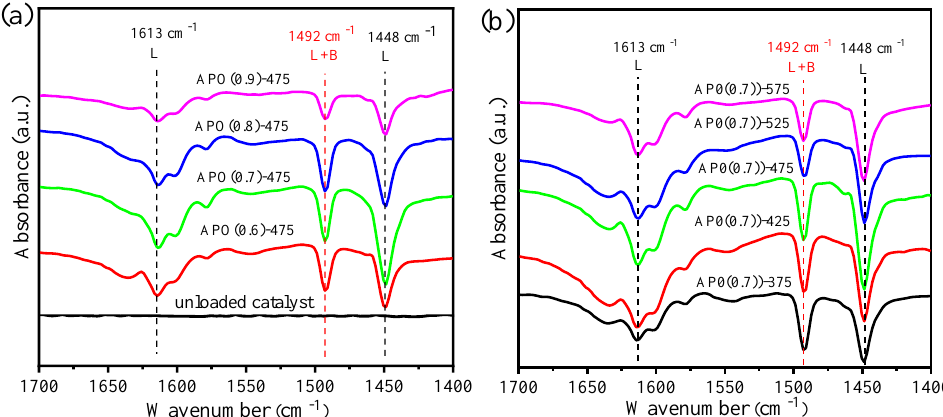
Figure 4. FT-IR spectra after pyridine adsorption of APO catalysts with ( a ) different P/Al ratios and ( b ) calcination temperatures. ( b ) calcination